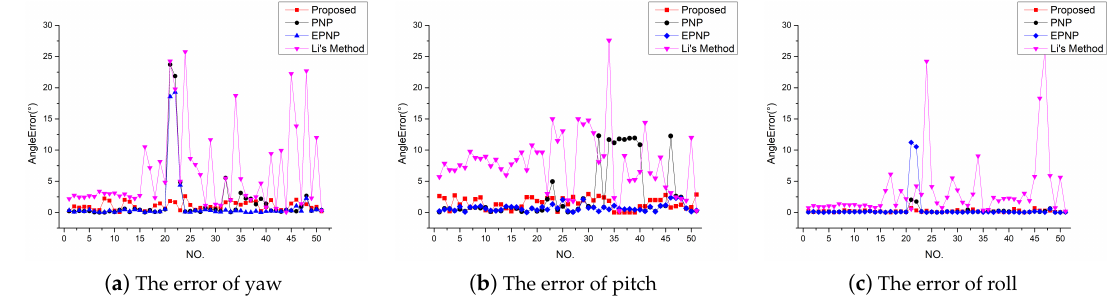
Figure 16. Attitude angle measured by comparison